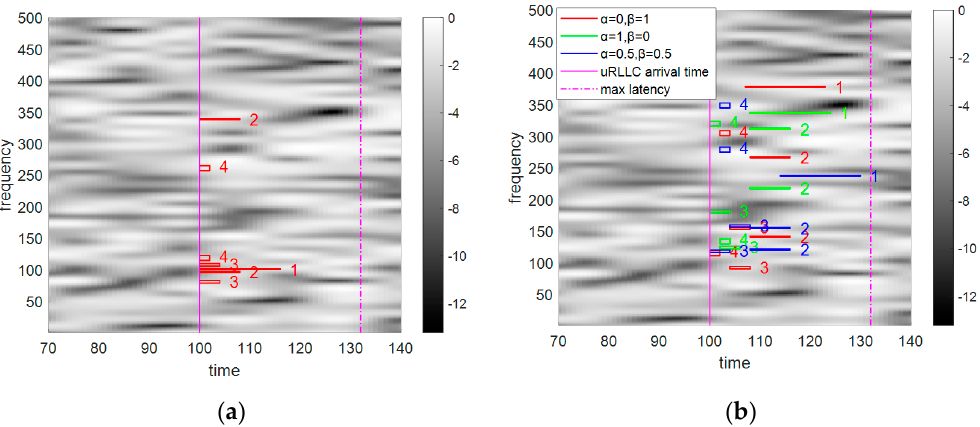
Figure 9. A diagram of the PRB positions of uRLLC traffic: ( a ) the conventional scheme; ( b ) the proposed scheme.